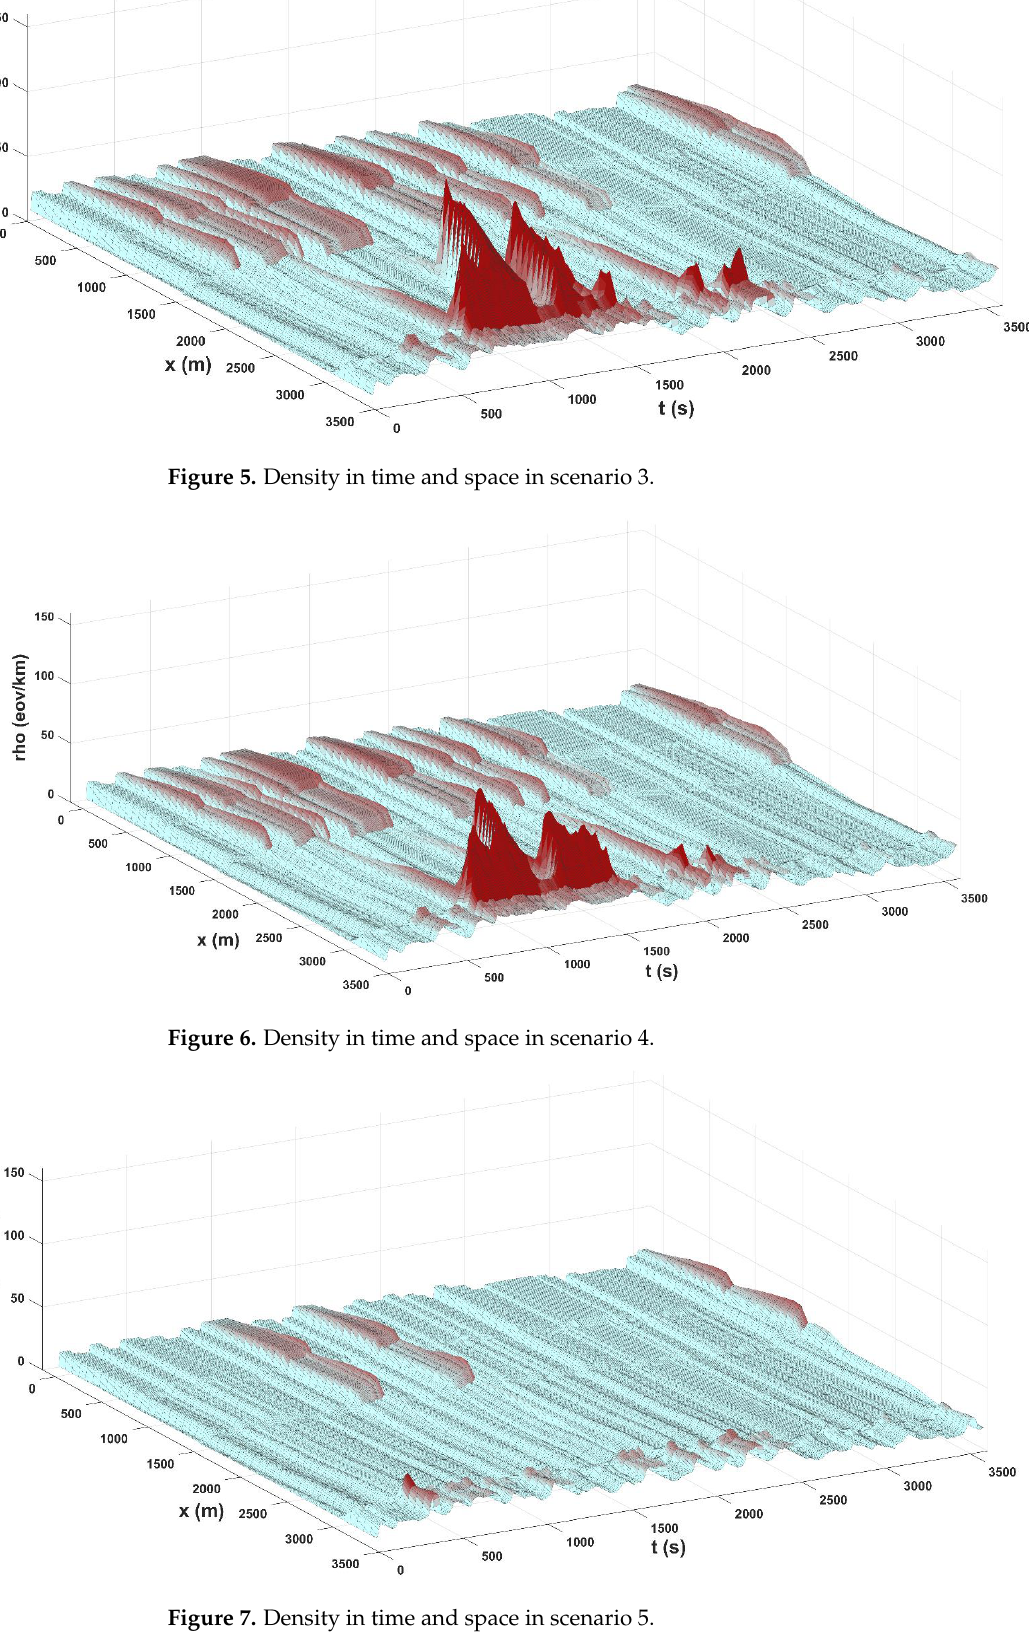
Figure 7. Density in time and space in scenario 5.